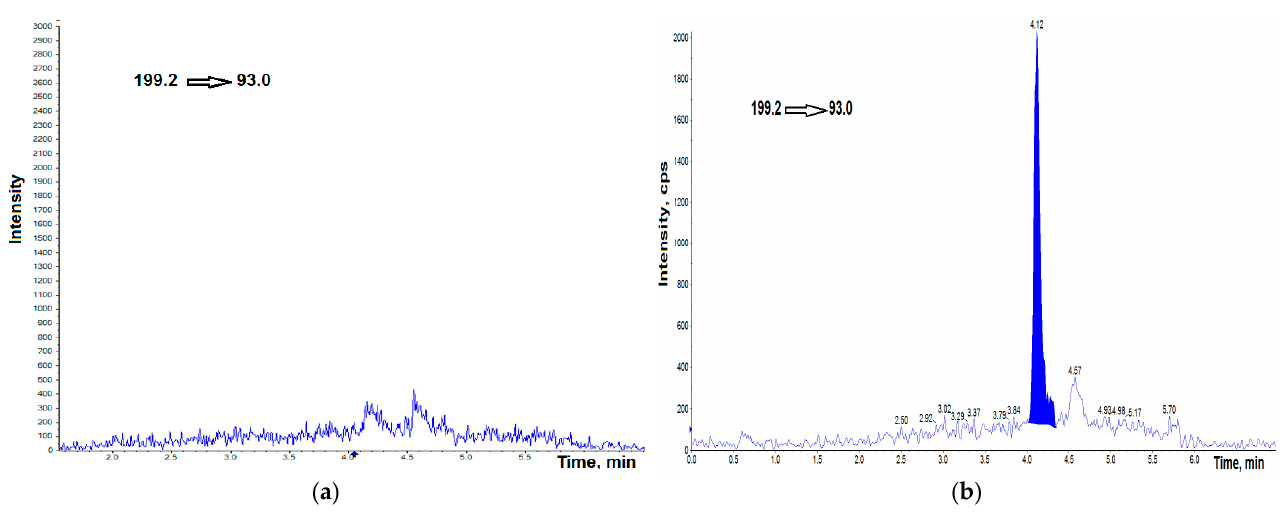
Figure 2. UHPLC–MS/MS chromatogram of BPF-free HA ( a ), BPF-free HA spiked with 0.25 ng g − 1 BPF ( b ). cps—counts per